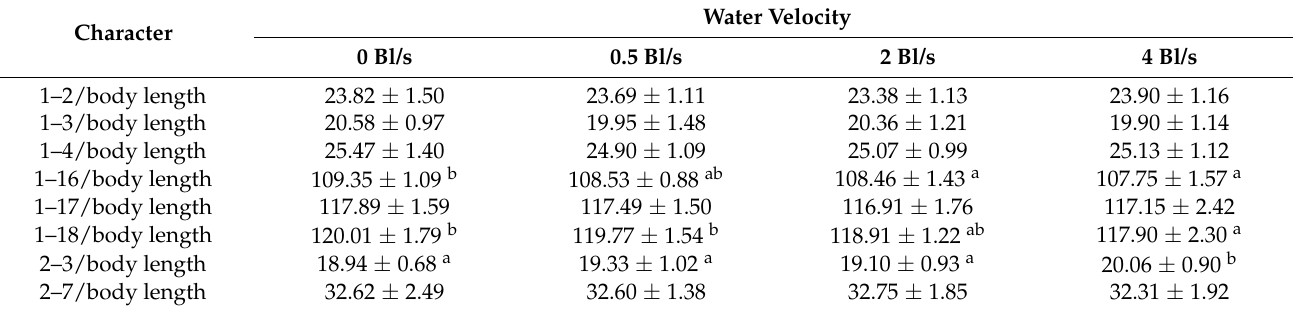
Table A1. Comparison of various indicators of grass carp in the lotic